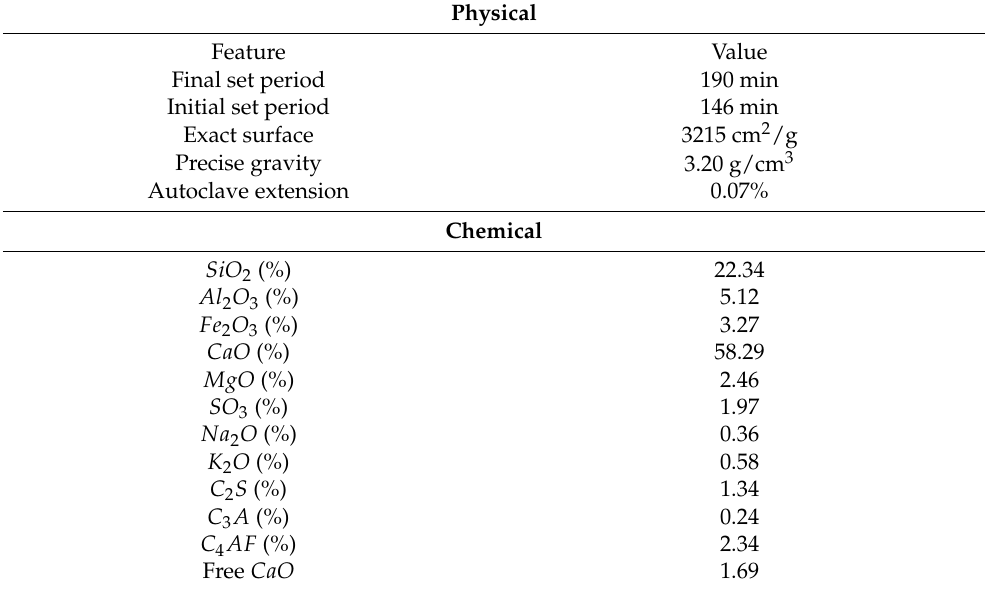
Table 2. Characteristics of the used aggregates.